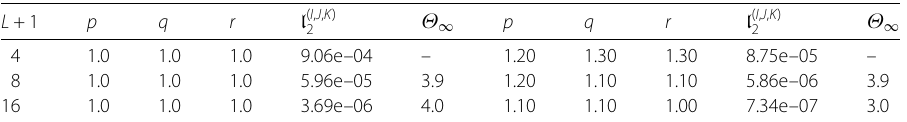
Table 3a Errors and order for UM-FOCS and EEG-TOCS in Example 5.3 L + 1 p